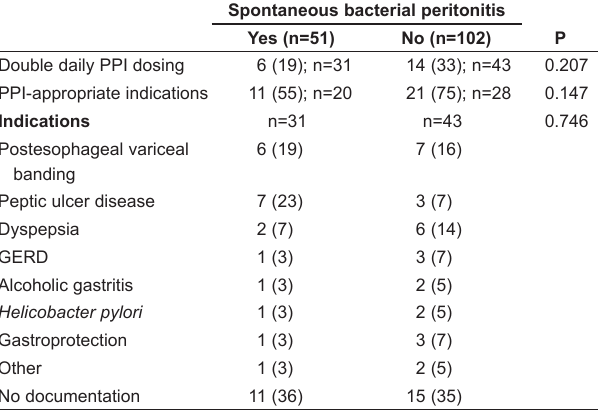
TAble 2 Details of proton pump inhibitor (PPI) use Spontaneous bacterial peritonitis